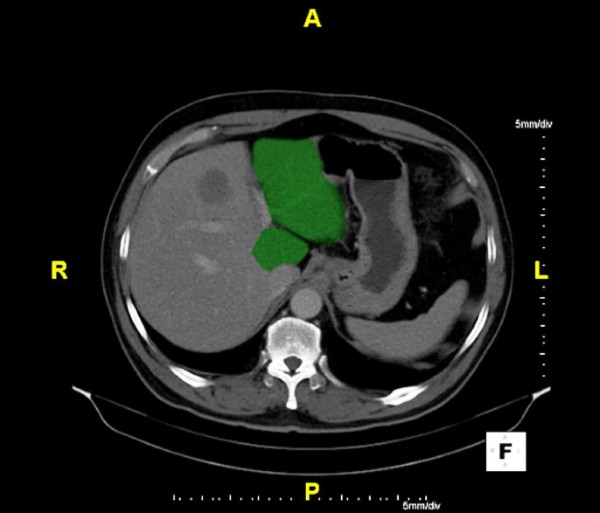
CLM with Small FLR Prior to Hepatic Resection. Patient with metastatic rectal carcinoma with right hepatic metastasis who was an operable candidate for right hepatectomy, but on preoperative computed tomography(CT; 5/12/09), the patient had a small left hepatic lobe and FLR.